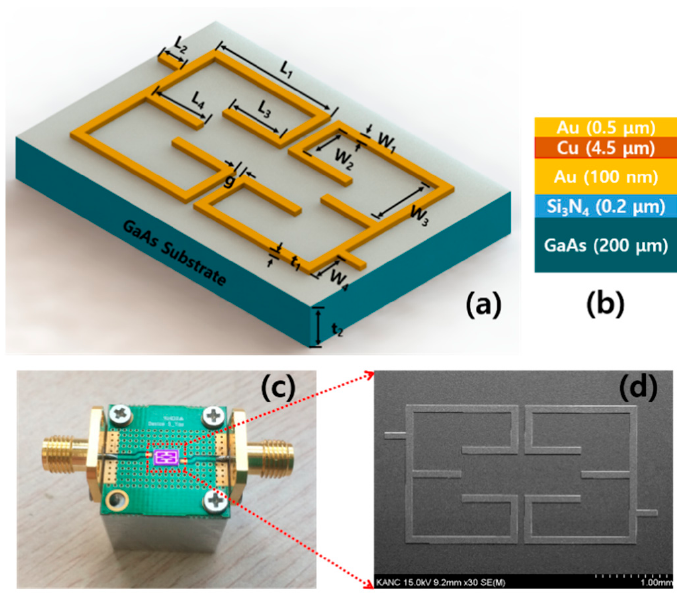
Figure 4. Proposed dual-mode BPF with folded open-loop resonators (FOLRs) and SLRs. ( a ) 3D schematic view of the BPF layout. ( b ) Layer information of fabricated BPF. ( c ) Picture of fabricated BPF on PCB with Al ground for measurement and ( d ) scanning electron microscopy (SEM) images of the fabricated BPF.